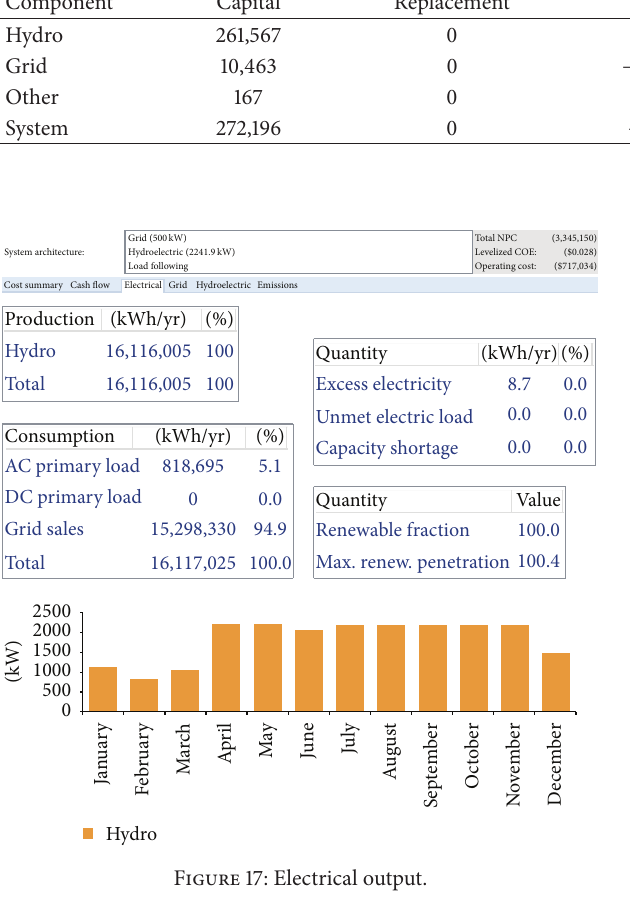
Figure 19: Energy sold to